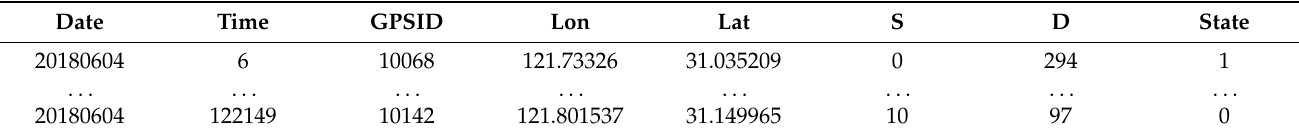
Table 2. Sample records of taxi trajectory